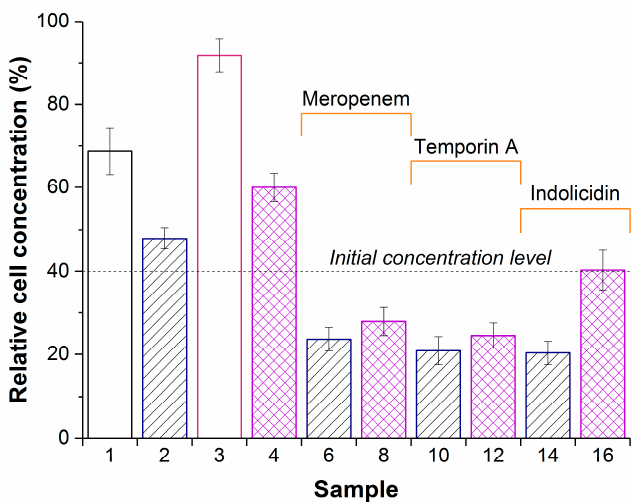
Figure 3. Concentration of Pseudomonas sp. in a suspension after 24 h exposure with PVA-CG (sample 1), PVA-CG / His 6 -OPH (samples 2,6,10, and 14), PVA-CG / BC (sample 3), or PVA-CG / BC / His 6 -OPH (samples 4,8,12, and 16) in the absence (samples 1,2,3, and 4) or in the presence of meropenem (samples 6 and 8), temporin A (samples 10 and 12), or indolicidin (samples 14 and 16). The dashed line indicates the cell concentration at zero time. Concentration of cells in the control without any additions after 24 h was assumed as 100%. Cultures treated by composite samples without His 6 -OPH but with antimicrobial agents for 24 h had almost the same bacterial concentration as the initial level.